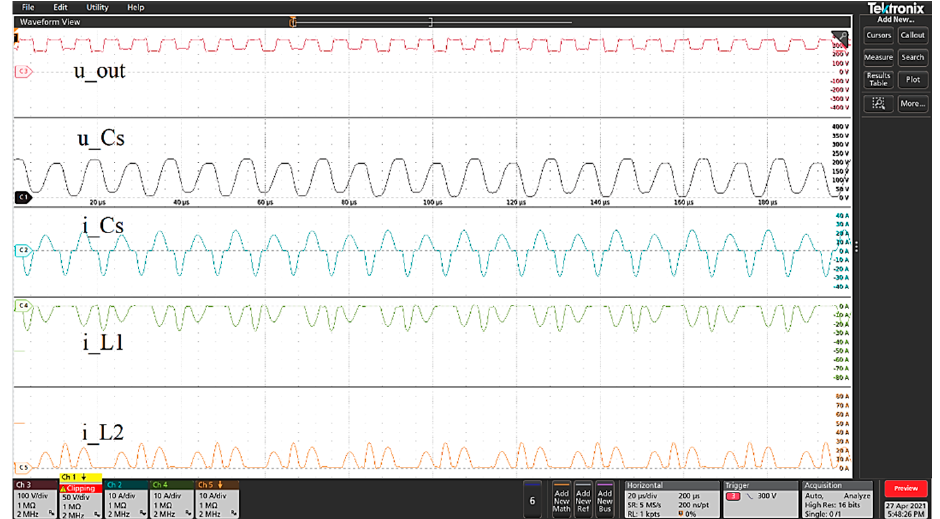
Figure 22. Steady state operation of the AIVB. Waveforms of voltage and current of the switched capacitor ( u CS [50 V/div], i CS [10 A/div]), currents of resonant chokes ( i L1 [10 A/div], i L2 [10 A/div]) and the output voltage of the inverter ( u OUT [100 V/div]); 20 μ s/div.